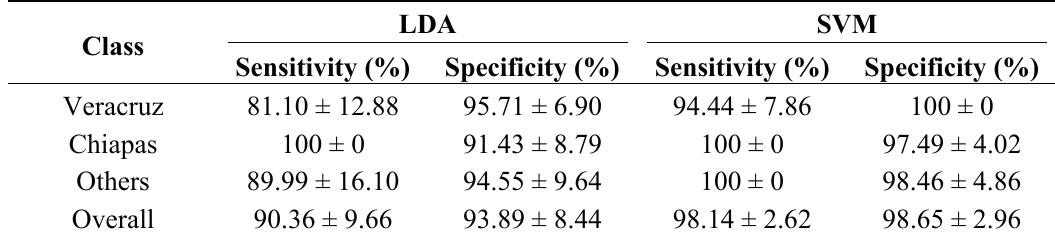
Table 3. Sensitivity and specificity for geographical origin classification for cross-validation